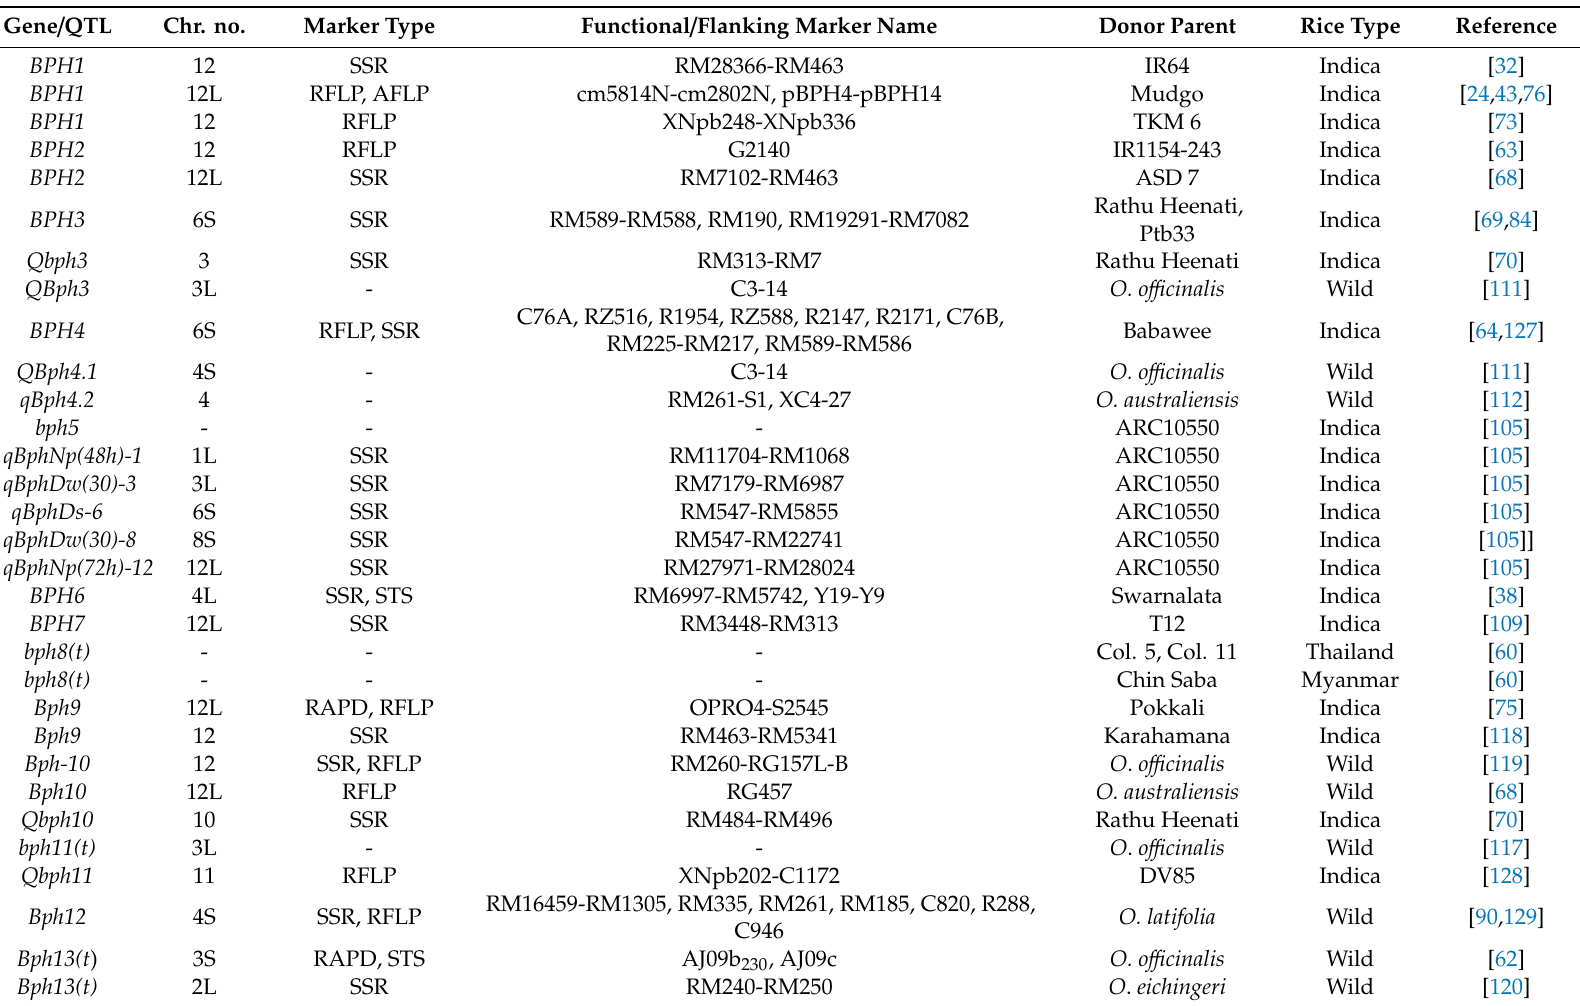
Table 3. List of some successfully mapped BPH resistance genes /